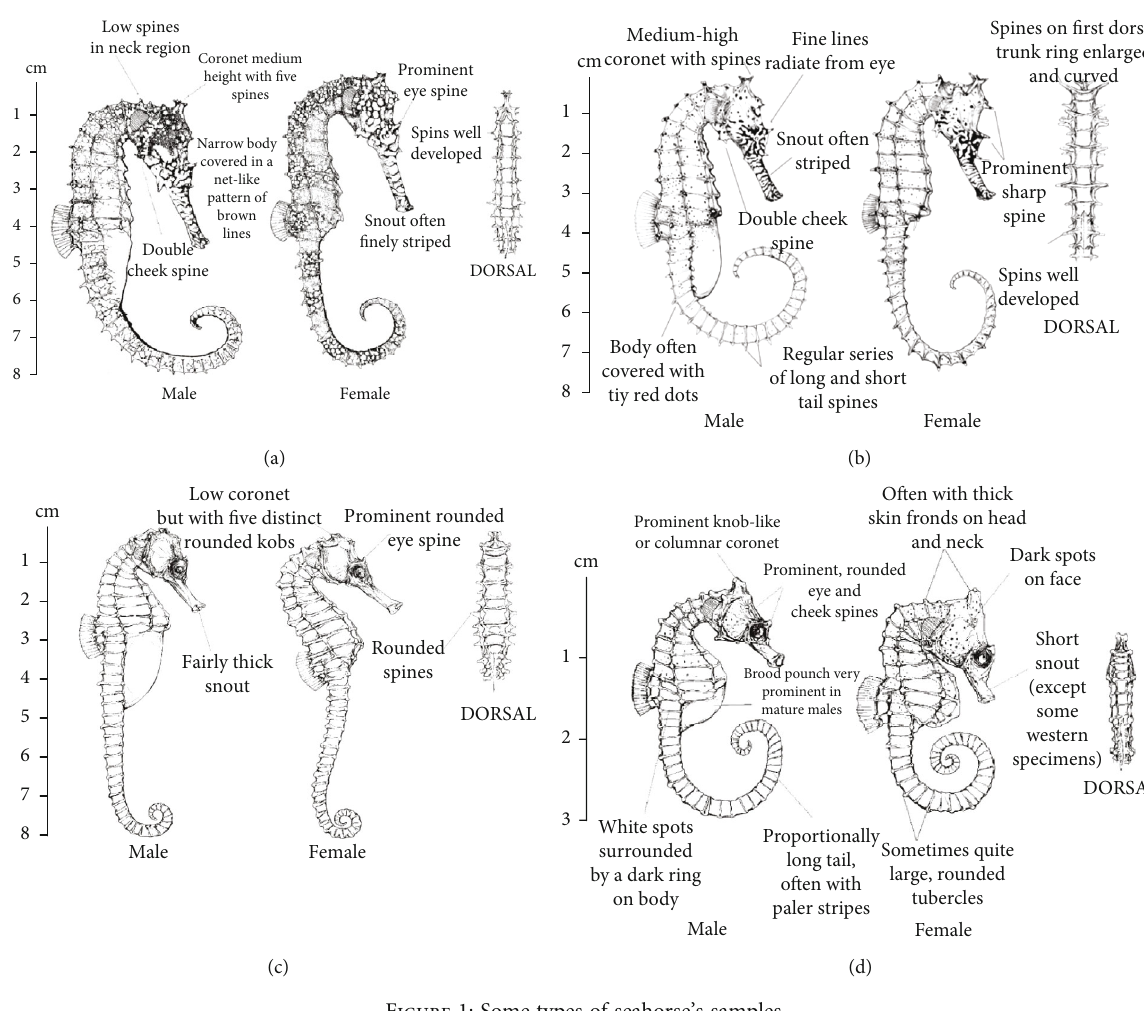
Figure 1: Some types of seahorse ’ s